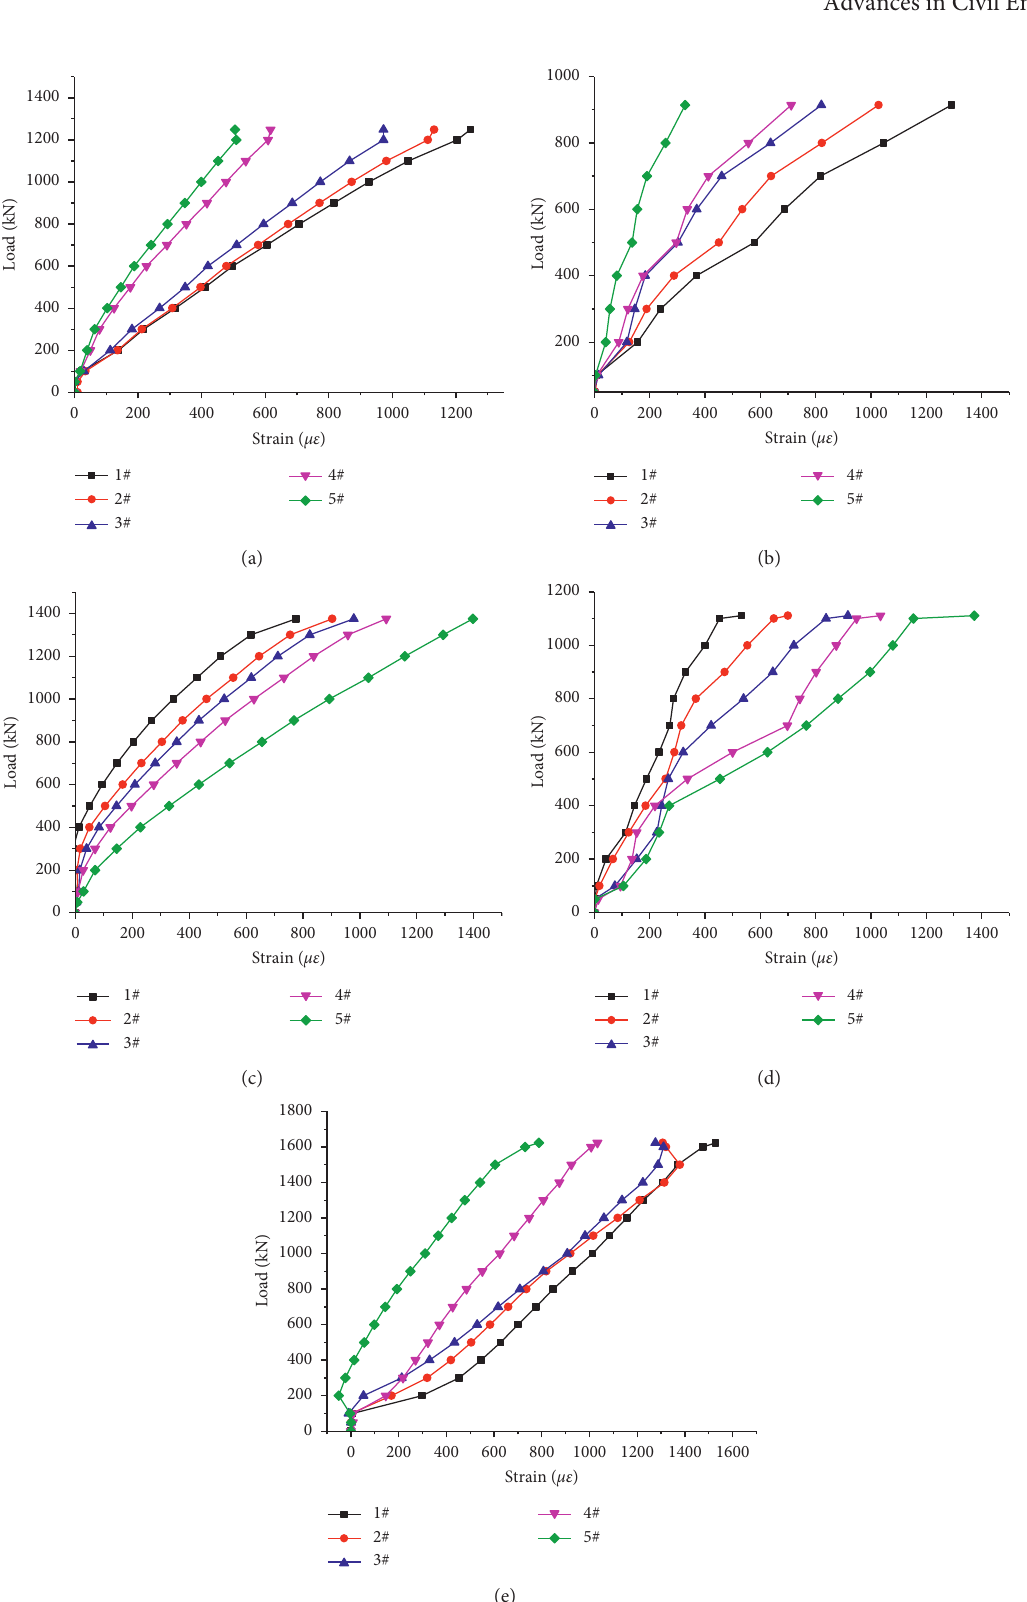
Figure 8: Load-strain diagrams of group U . (a) U35-L-20-1. (b) U35-L-40-1. (c) U35-R-20-1. (d) U35-R-30-1. (e)